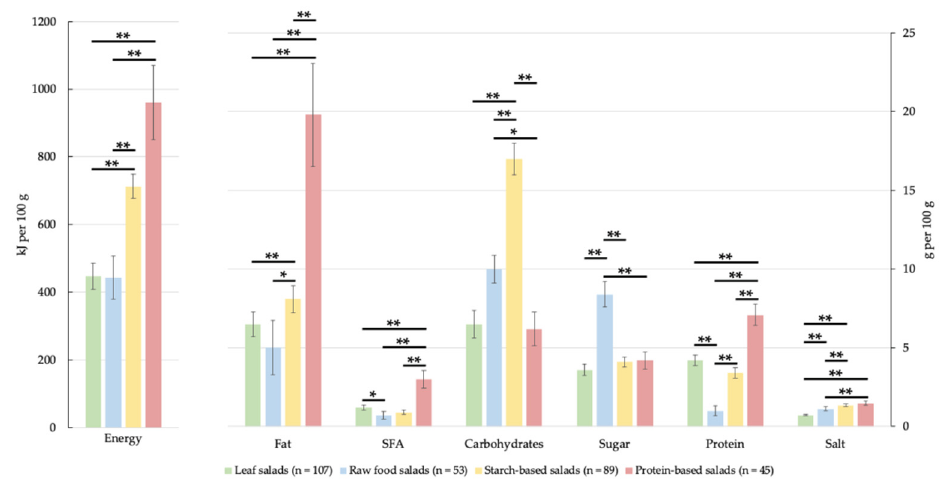
Figure 2. Comparison of the median Big7 values of the main groups. Plot of all Big7 medians in kJ/g per 100 g for each main group. Shows the significant differences in energy [kJ per 100 g] and total fat, SFA, total carbohydrates, sugar, protein, and salt content [g per 100 g] between the main groups according to Kruskal-Wallis test plus pairwise comparisons with Bonferroni correction. Error bar shows 95%-CI; *: p < 0.05; **: p < 0.01; n, number of salads; SFA, saturated fatty acids. Table 3. Comparison of the median nutriRECIPE-Index-scores and total nutriRECIPE-Index values of the main groups.